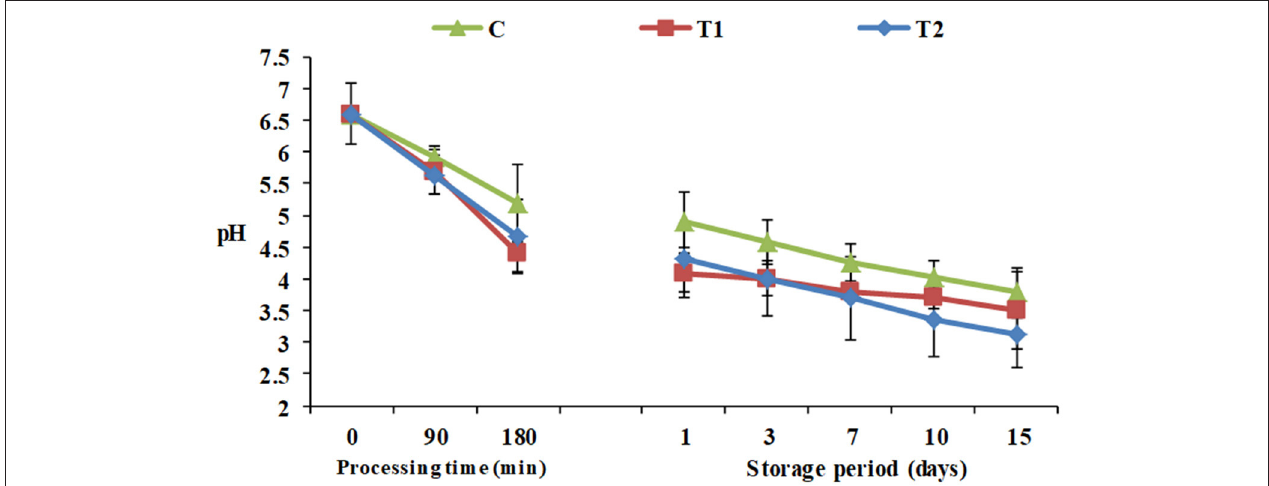
FIGURE 1 | pH of yogurt products during processing and cold storage. C, control plain yogurt; T1, Pro-WPI 10% WPI-enriched concentrated yogurt; T2, Pro-WPI 20% WPI-enriched concentrated yogurt.